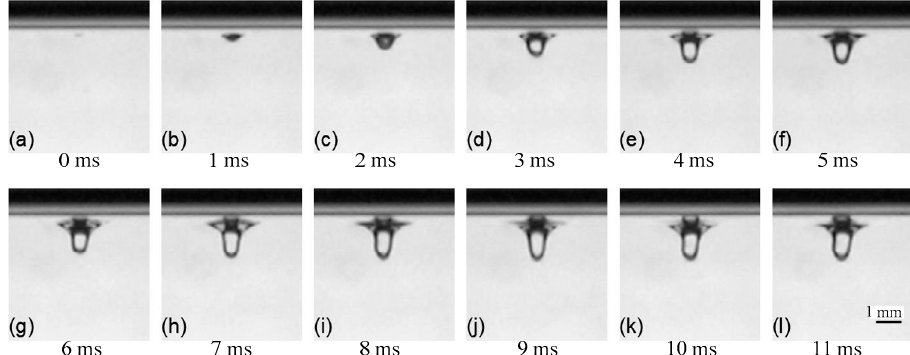
Figure 4. Formation of keyhole in analogy method: ( a ) No keyhole formed at 0 ms; ( b ) Keyhole at 1 ms;